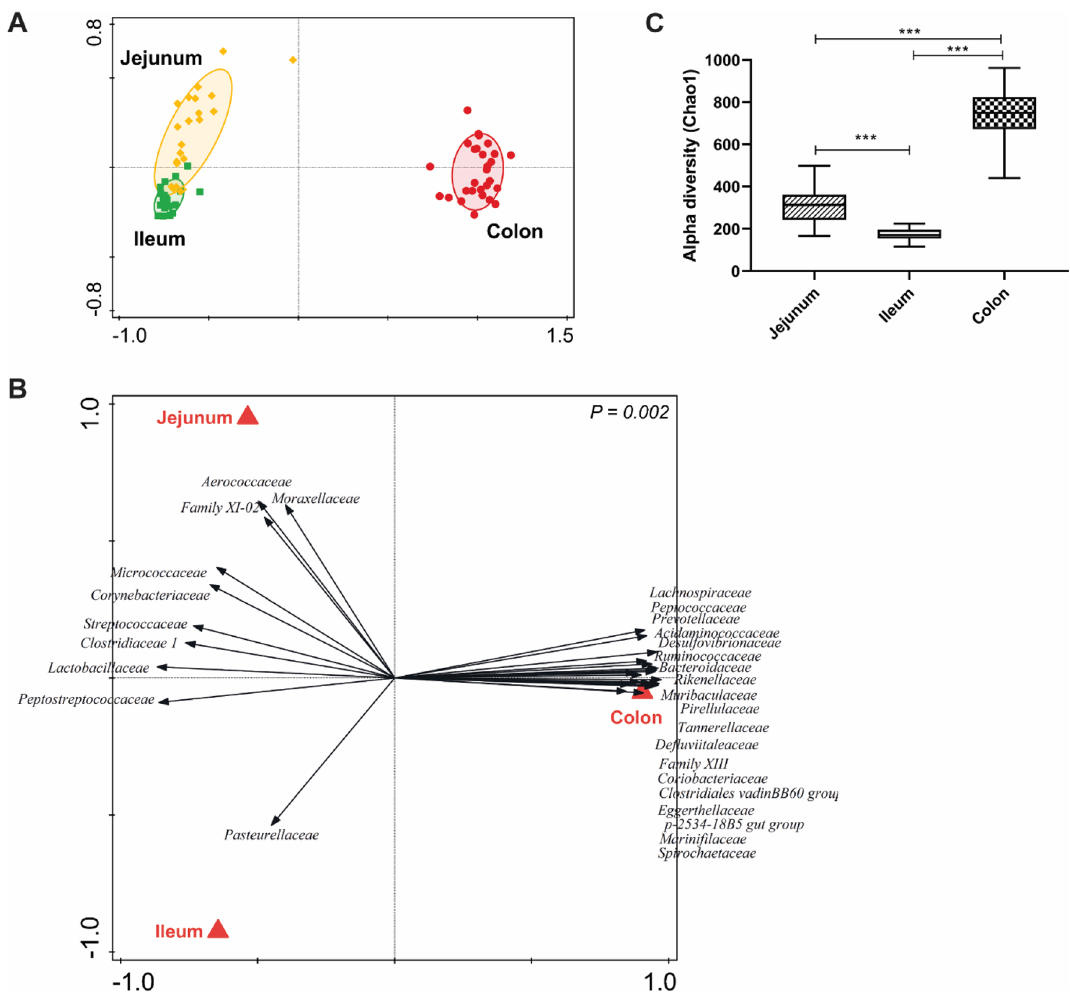
Figure 1. Microbiota composition along the intestinal tract. ( A ) Principal component analysis of jejunum, ileum and colon microbiota (PC1 = 66.66%, PC2 = 4.76%) at genus level. ( B ) Redundancy analysis (explained variation = 67.8% P = 0.002) of intestinal location with associated microbial groups at family level. Microbial groups visualized in this figure have a minimum fit value of at least 40% on the horizontal axis and a response score > 0.63 and > 0.80 for jejunum/ileum and colon, respectively. Specific microbial families which are differentially abundant in jejunum/ileum were enforced in this graph). ( C ) Alpha diversity (Chao1 bias corrected) comparison among jejunum, ileum and colon. Significant differences between groups were assessed by student t test or Mann–Whitney U test (***: P <